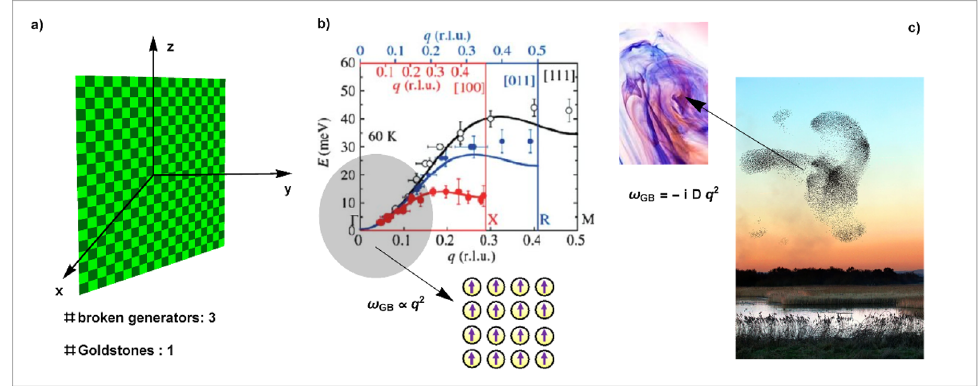
Figure 2 . Three di(cid:11)erent cases of \anomalous Goldstones". a) A plane in a (cid:12)xed position in 3-dimensional space. There are three broken generators but only one Goldstone mode. b) The case of a ferromagnet. There are two broken generators and only one Goldstone which is quadratic. The data shown are taken from [28]. c) A (cid:13)ock of birds. The Goldstone boson has a di(cid:11)usive dispersion relation